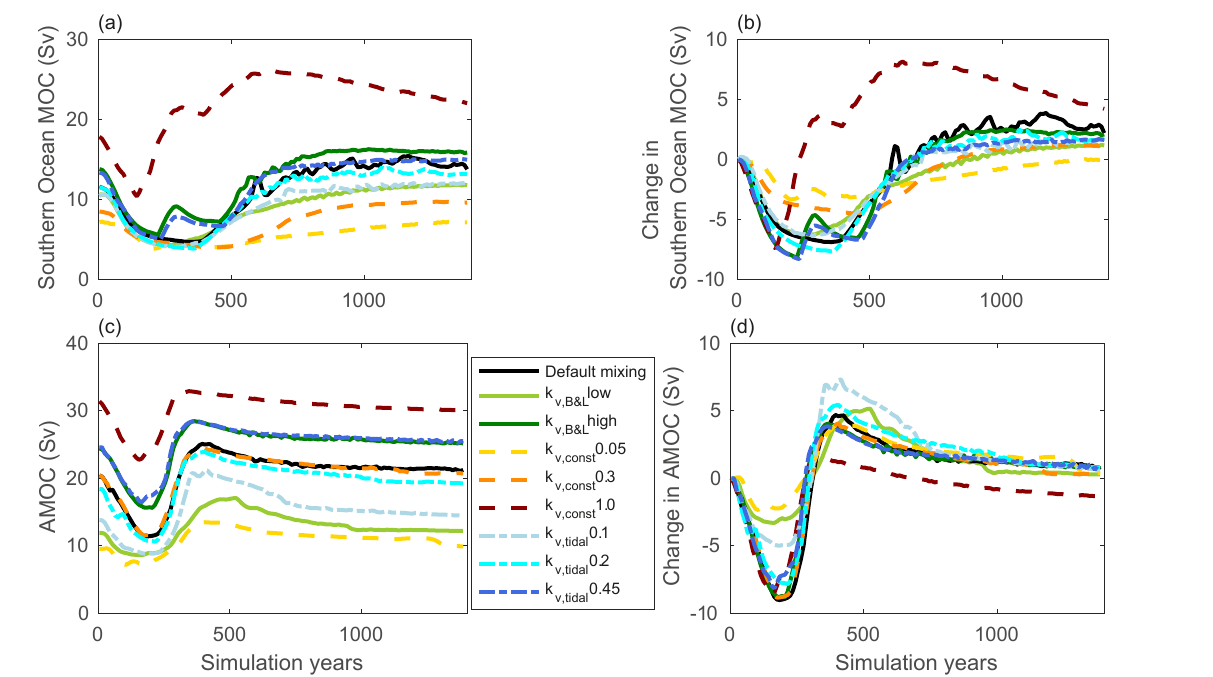
Figure 6. Meridional overturning circulation (MOC) in the Southern Ocean (a) and in the North Atlantic (c) . Change in the MOC relative to year 0 in the Southern Ocean (b) and in the North Atlantic (d) . The MOC in the Southern Ocean and the North Atlantic are computed from the minimum and maximum respectively of the zonally averaged stream function below a depth of 400m. The stream function is calculated from decadal averages of the meridional velocity. The maximum of the zonally averaged stream function occurs between 30 and 40 ◦ N and the minimum occurs between 0 and 70 ◦